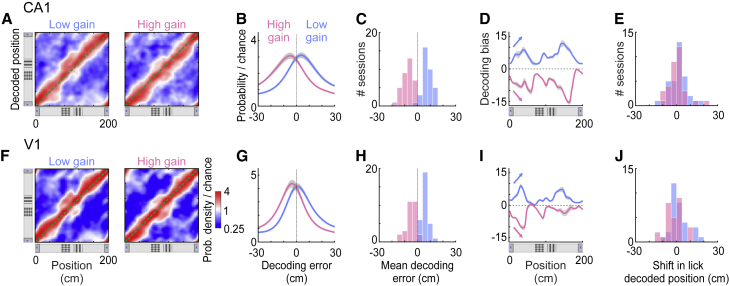
Positions Encoded in V1 and CA1 Populations Are Influenced by Distance Traveled and Consistent with Behavior(A) Distribution of positions decoded from CA1, as a function of the animal’s actual position, averaged across trials with low (left) or high (right) gain. Gray band shows ± SEM.(B) Distribution of errors in the position decoded from CA1 at low (blue) and high (pink) gain, averaged across sessions.(C) Distribution of mean decoding errors across CA1 recording sessions at low (blue) and high (pink) gain.(D) Decoding bias (i.e., most likely CA1 decoding error) at low (blue) and high (pink) gain, calculated across positions. Arrows indicate how the bias would accumulate if the decoded position depended only on distance traveled. Gray band shows ± SEM.(E) Distributions of the shift in mean lick position across sessions, using the positions decoded from CA1 at low (blue) and high (pink) gain, showing no significant differences.(F)–(J) Same as (A)–(E) for V1.